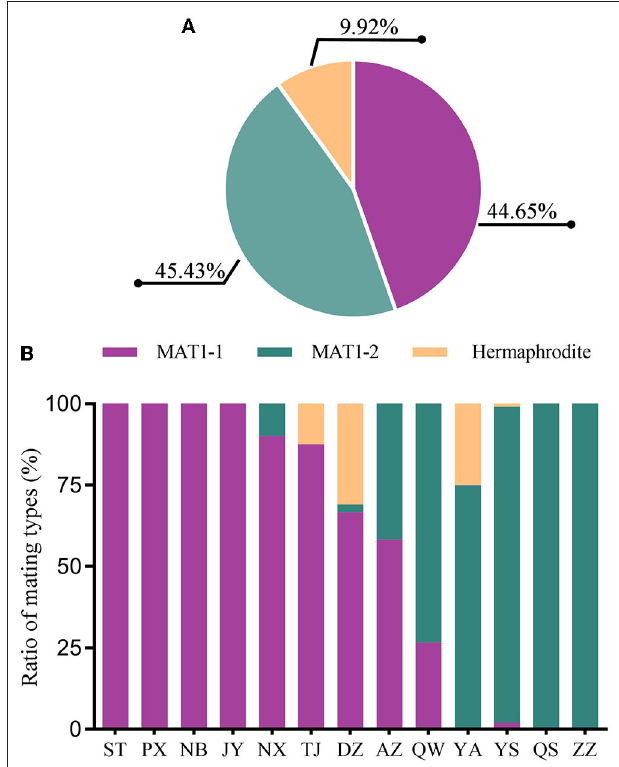
FIGURE 7 | The composition and distribution of MAT1-1 and MAT1-2 isolates in the M. oryzae population in the Sichuan Basin. (A) The composition of MAT1-1 and MAT1-2 in the isolates. (B) The distribution of isolates with different mating types in the Sichuan Basin.